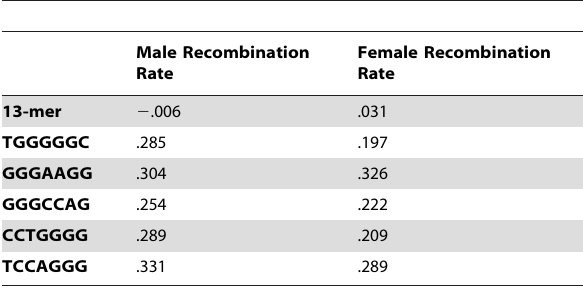
Table 4. Correlations between recombination rates and motif